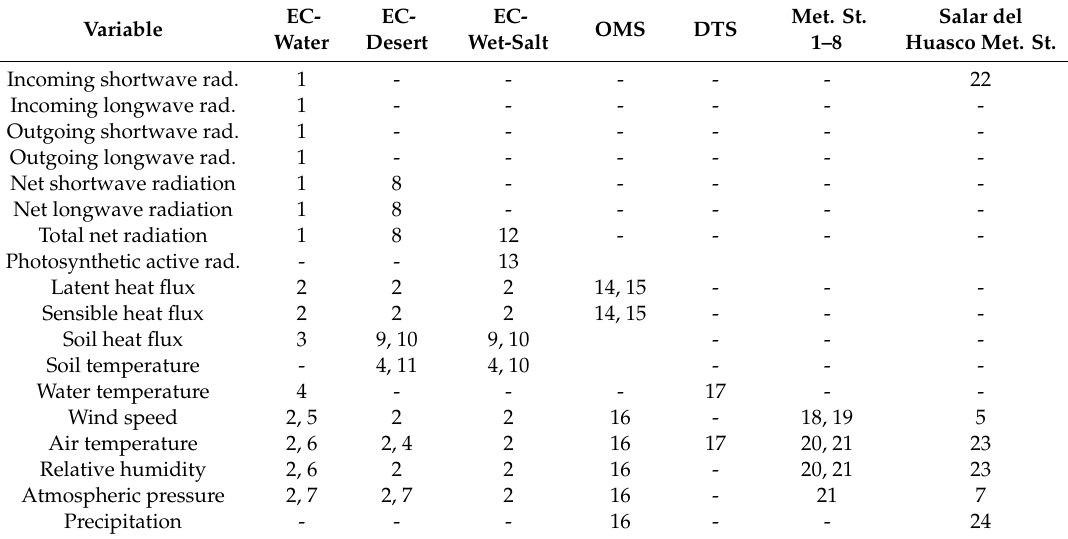
Table 1. Description of the instrumentation used in the E-DATA field experiment. Numbers refer to the footnotes of the Table, where sensor type and manufacturer information is provided.